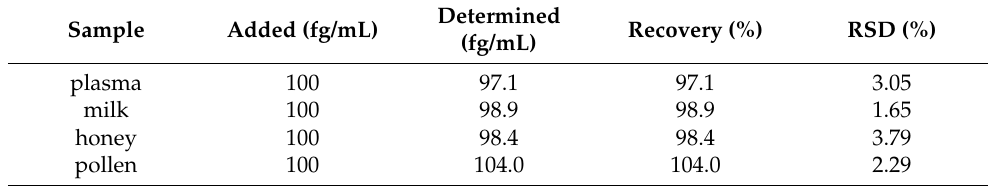
Table 3. Test results of simulated sample ( n =